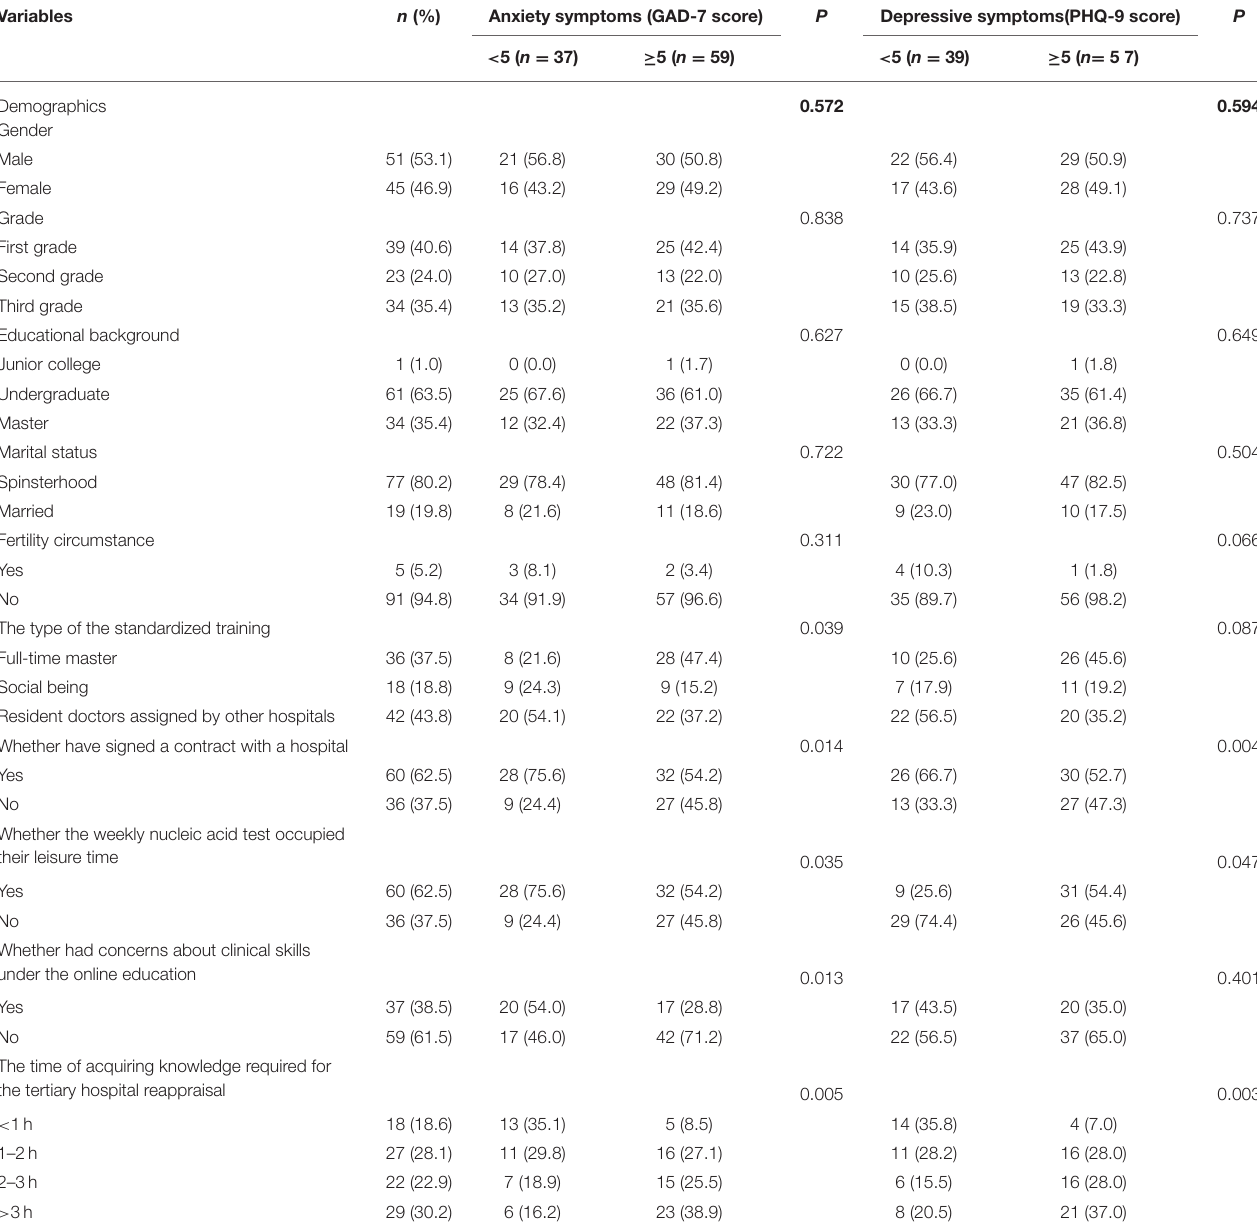
TABLE 1 | Sample characteristics and univariate analysis of variables related to symptoms of anxiety and depression.